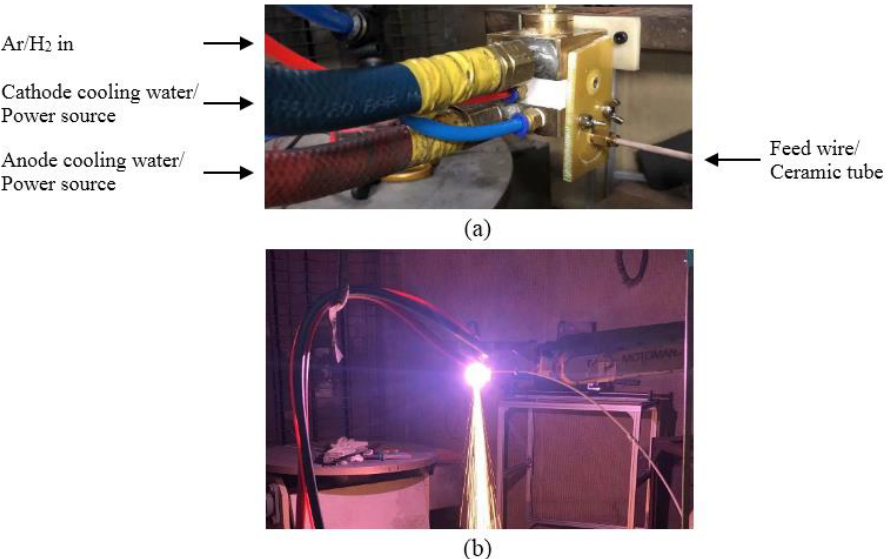
Figure 4. View of plasma spraying with wire feeding: ( a ) Plasma spraying torch, ( b ) Plasma wire spraying process. spraying process. Table 1. Plasma spraying parameters.